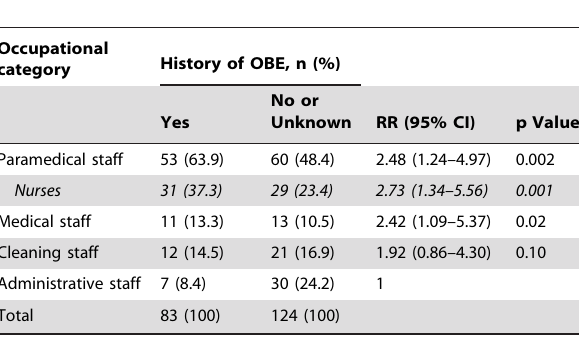
RR, relative risk; 95% CI, 95% confidence interval.